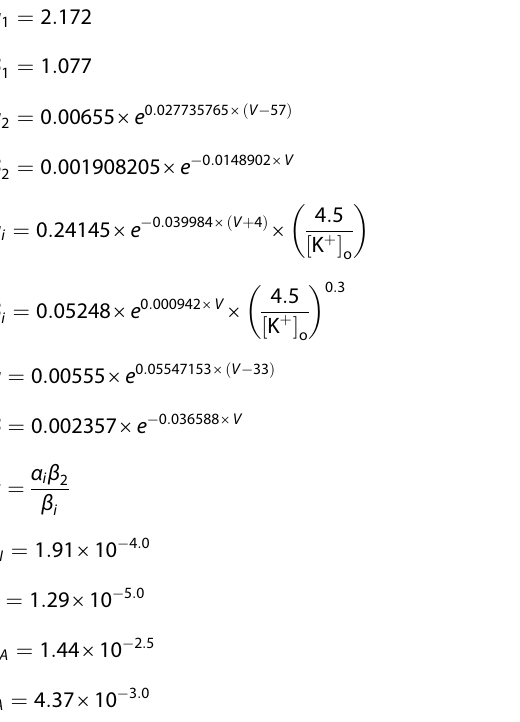
Transition rates for the T618I mutant channel after the application of quinidine (ms − 1 )